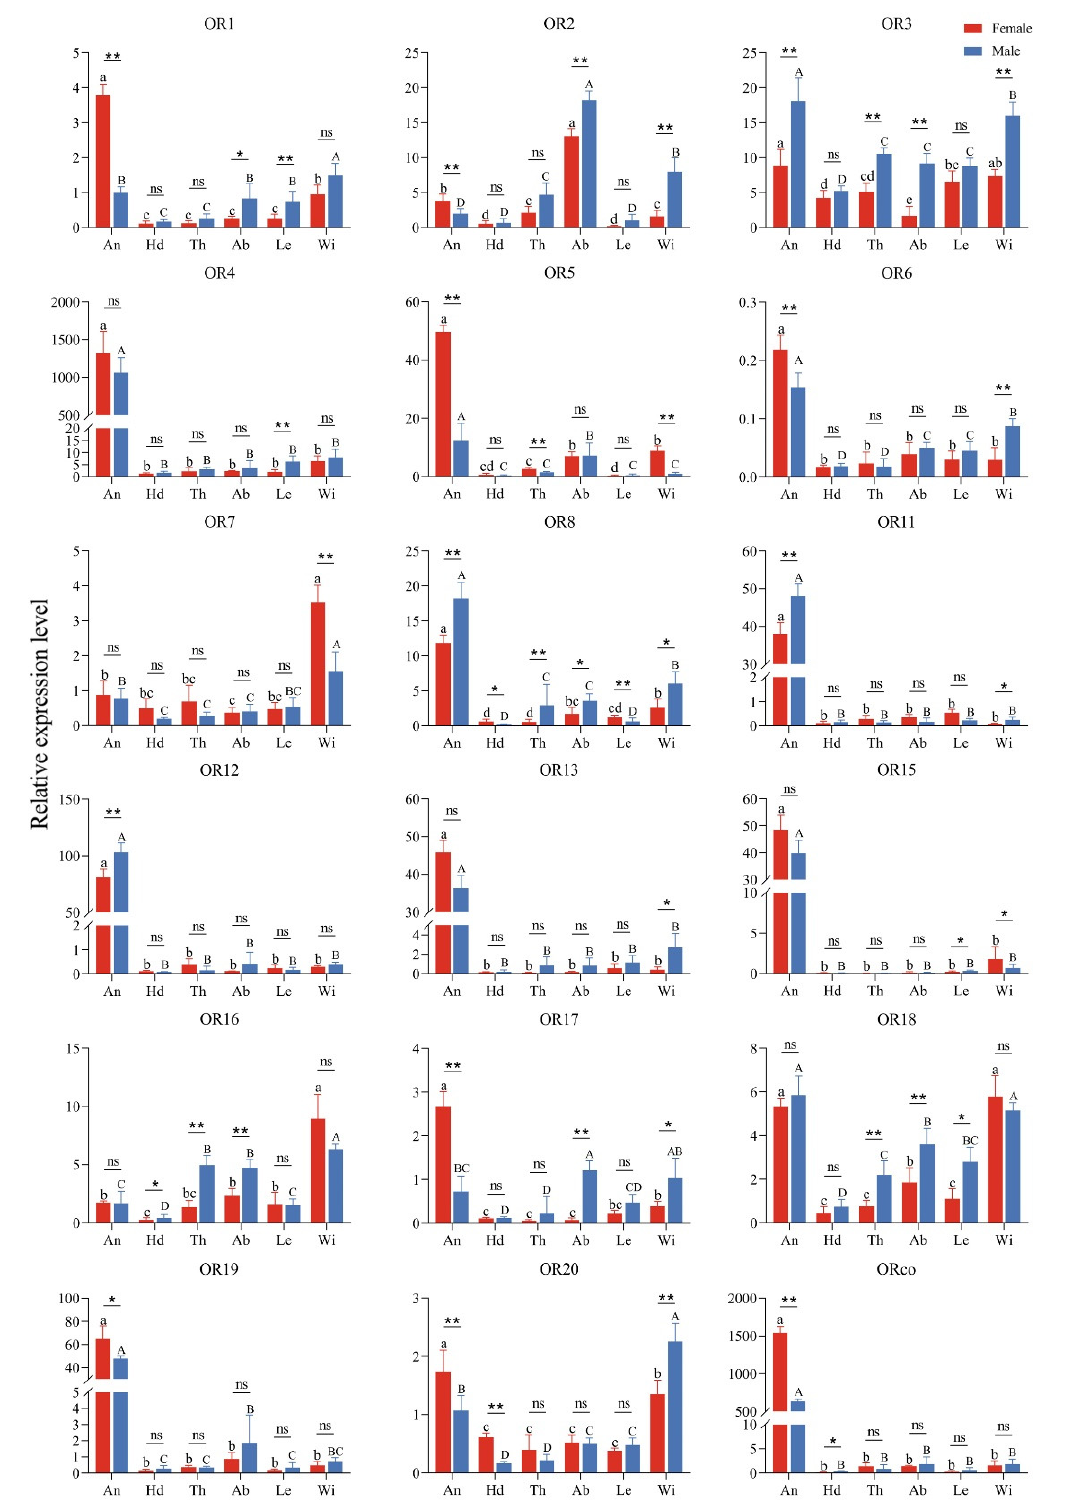
Figure 1. Expression profiles of GdauORs in different tissues of female and male adults. An: Antennae; Hd: Head without antennae; Th: Thorax; Ab: Abdomen; Le: Leg; Wi: Wing. Error bars represent the standard error of three independent experiments. Different capital and small letters above bars indicate significant difference among different tissues of females and males, respectively (Duncan’s test; p < 0.05). The asterisk above bars indicates significant difference between males and females ( T -test; *: p < 0.05; **: p < 0.01; ns: No significant